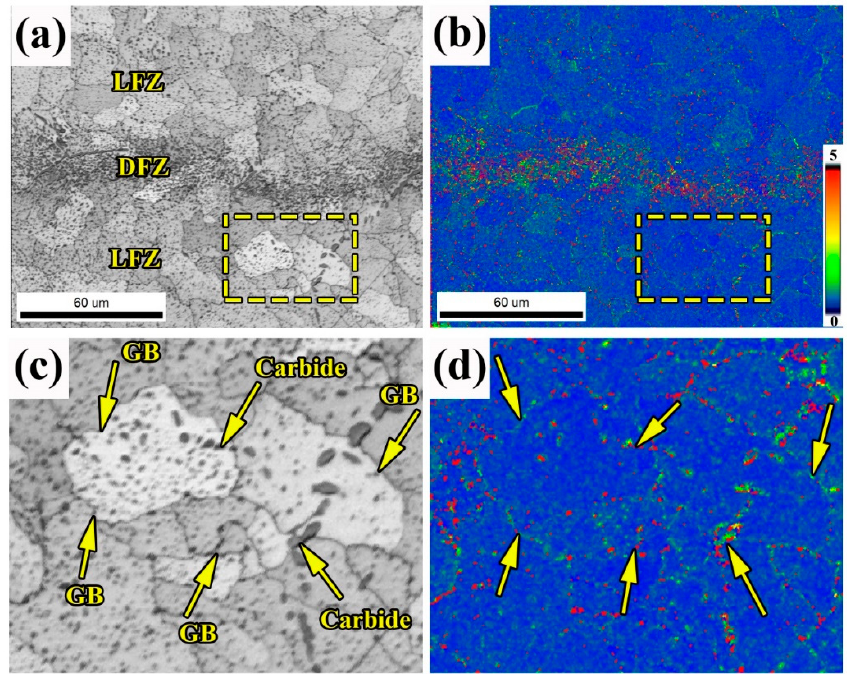
Figure 6. The microstructure and kernel average misorientation (KAM) of the flow lines: ( a ) microstructure image; ( b ) KAM image; (( c , d )) the zone marked by a yellow box in ( a , b ).